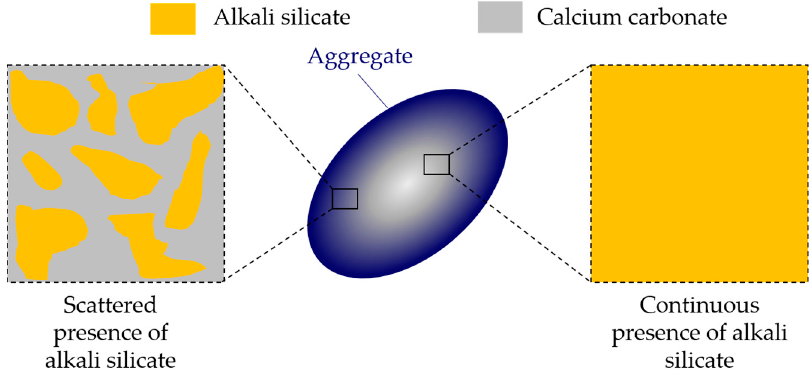
Figure 17. Schematic representation of the different presences of alkali silicate.